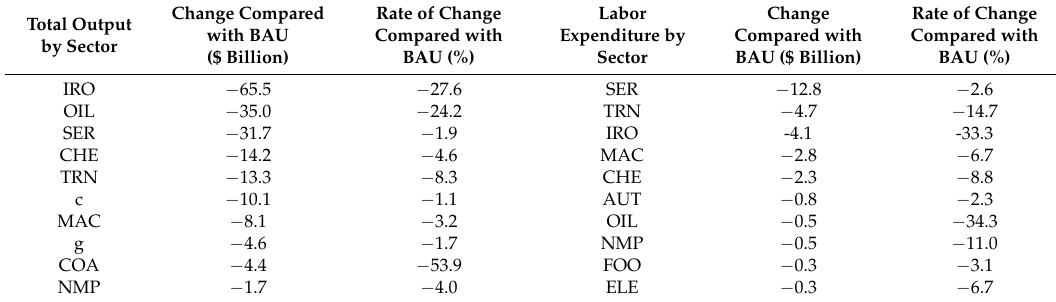
Table 8. POL_22 scenario ripple effect by sector.